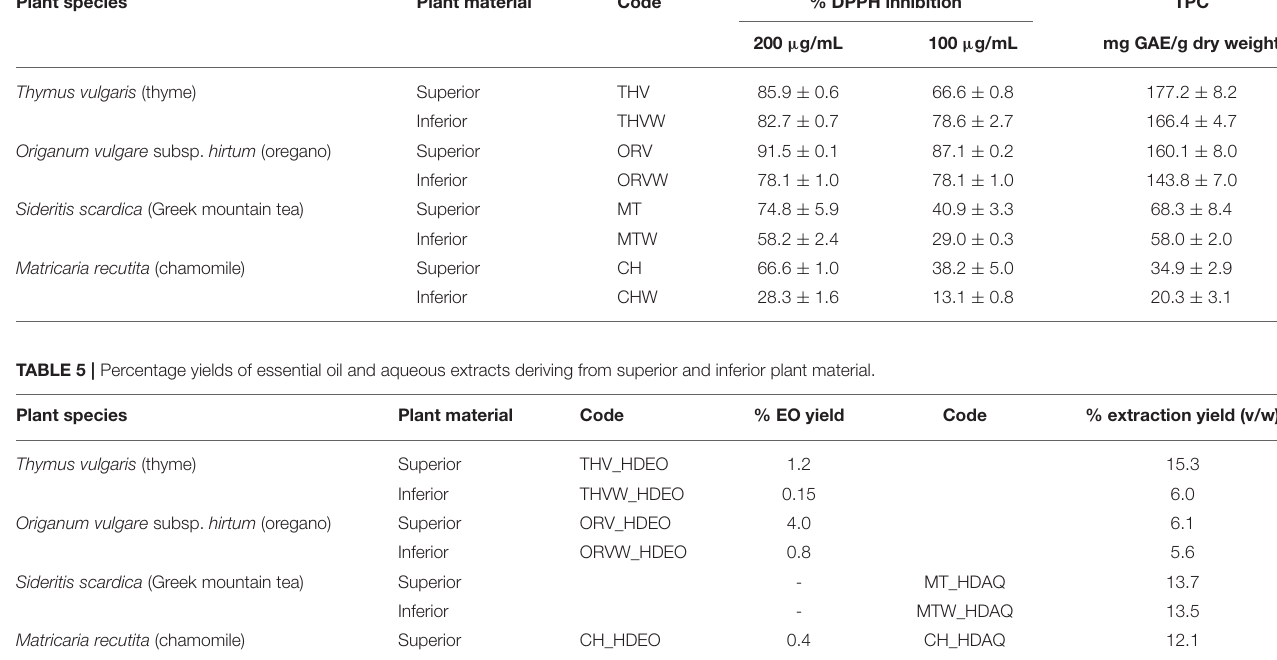
TABLE 4 | Total phenolic content (TPC) and antioxidant capacity of hydroalcoholic extracts. Plant species